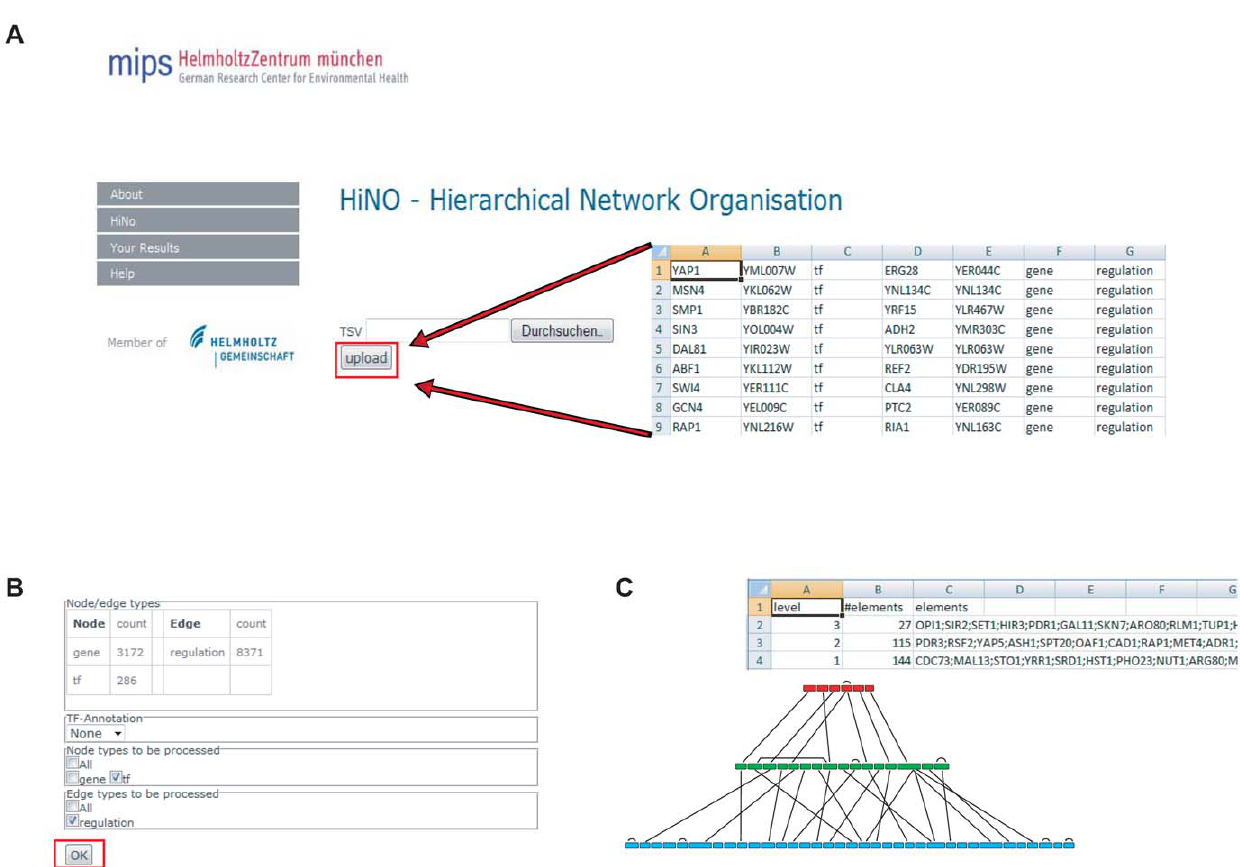
Figure 4. Web interface. An illustration of the user-friendly web-interface for HiNO is shown. The user can upload ( A ) a text file containing the representation of any directed network. Afterwards ( B ) the user retrieves information about node and edge types within the uploaded network and can decide which types should be used for the hierarchy extraction. Additionally, TF annotation can be added for human or mouse networks. ( C ) Information about the extracted hierarchical structure can be downloaded either as text file or in a graphical representation.